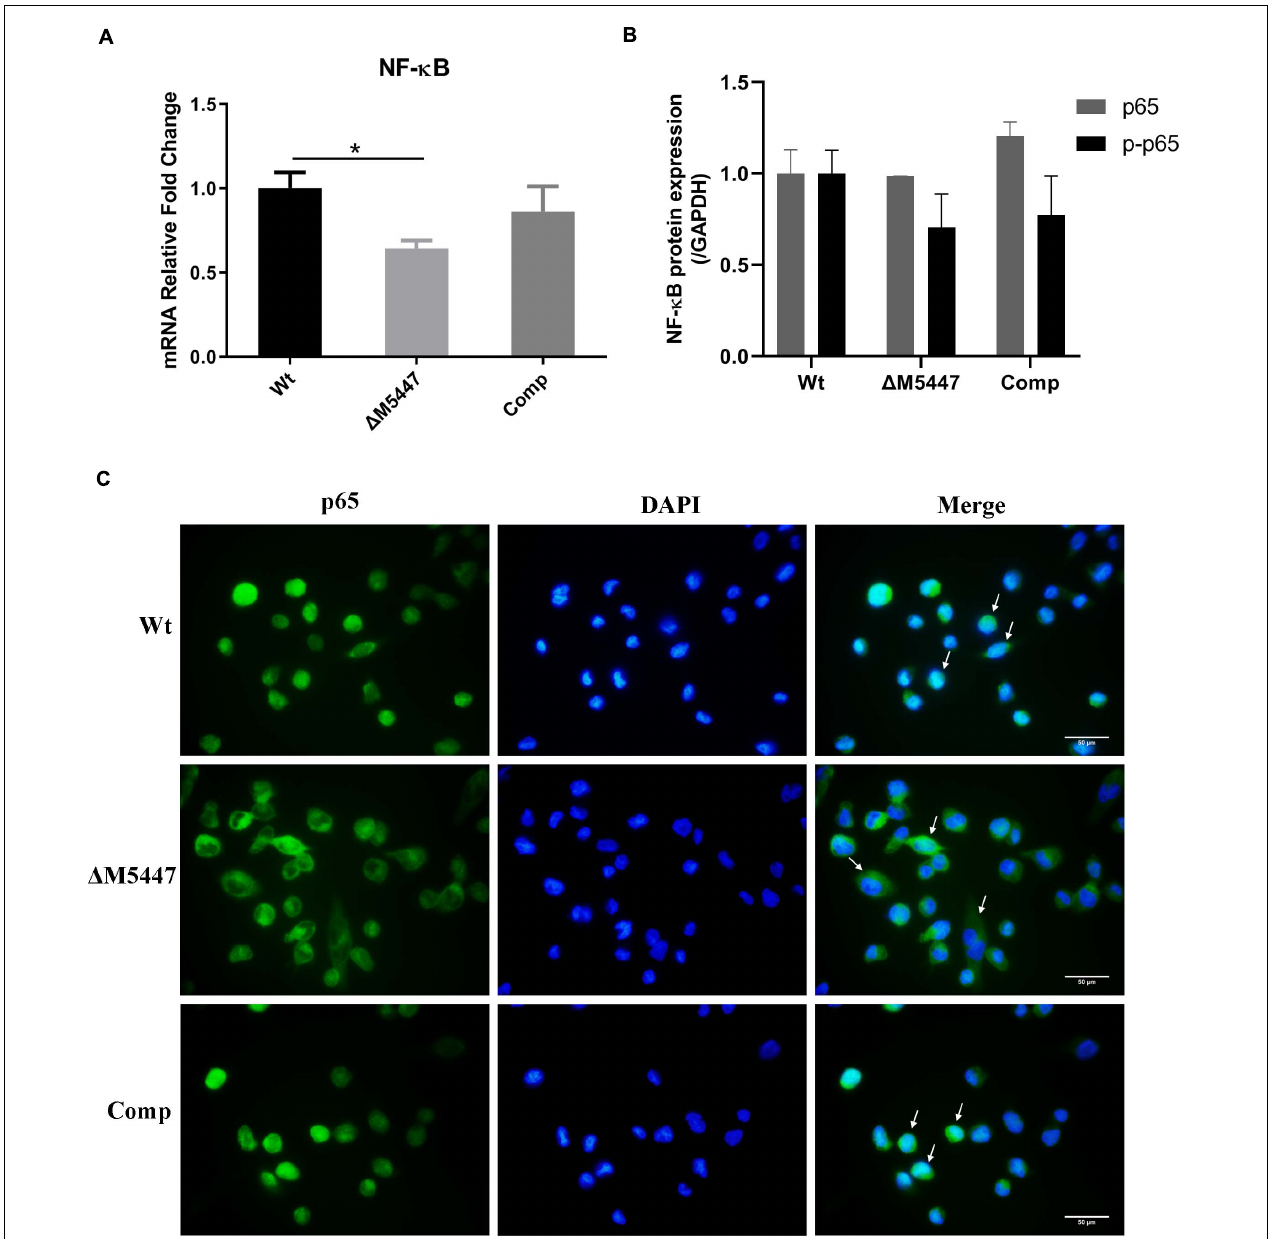
FIGURE 6 | The expression and activation of NF- κ B were decreased in (cid:49) M5447-infected macrophages. THP-1 macrophage cells were infected with Wt, (cid:49) M5447, and Comp strains for 3 h. (A) The total RNA was extracted from infected THP-1 cells at 24 h post-infection, and the transcriptional level of the p65 subunit of NF- κ B was evaluated by qPCR. (B) The total protein was extracted from infected THP-1 cells at 24 h post-infection, and the protein levels of p65 and p-p65 were determined by western blot. Densitometric analyses of images of WB have been presented. (C) The translocation of the p65 subunit of NF- κ B from cytosol to nucleus was evaluated by fluorescence microscopy at 24 h post-infection. The cells were fixed and stained with p65 antibody and DAPI. The white arrows indicate the translocation of the p65 subunit of NF- κ B. Scale bars, 50 µ m. Data were shown in representative results from three independent experiments. Statistical analyses were performed by the method of two-tailed t -test (* p <